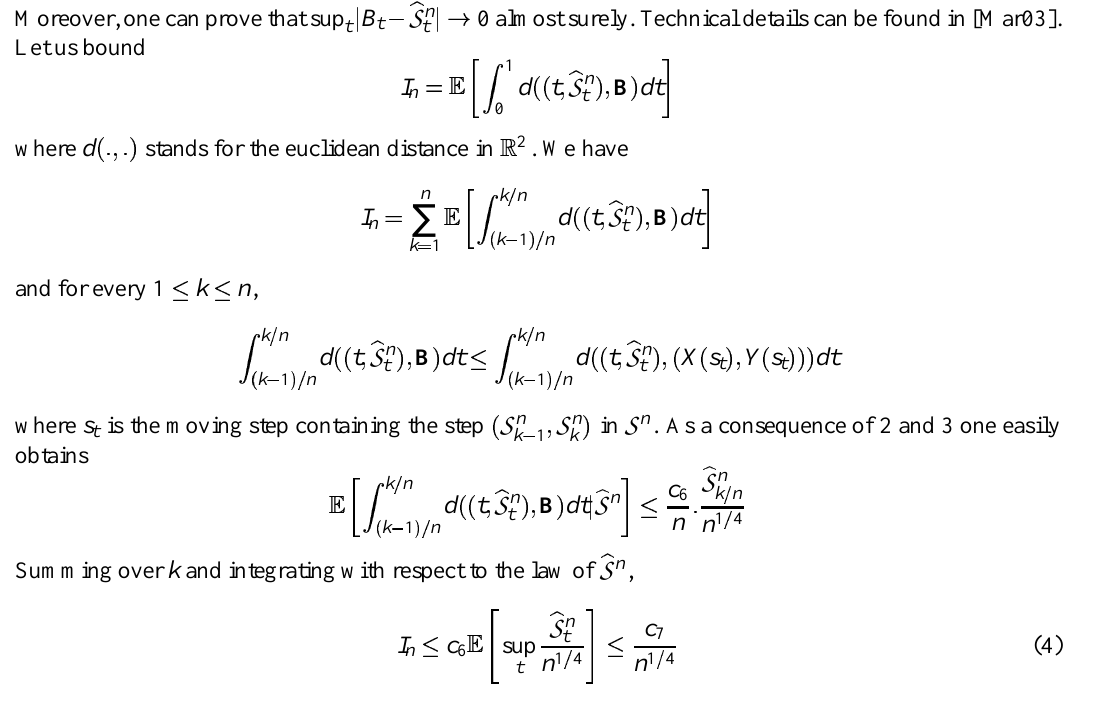
i k , with probability (cid:6) (cid:6)